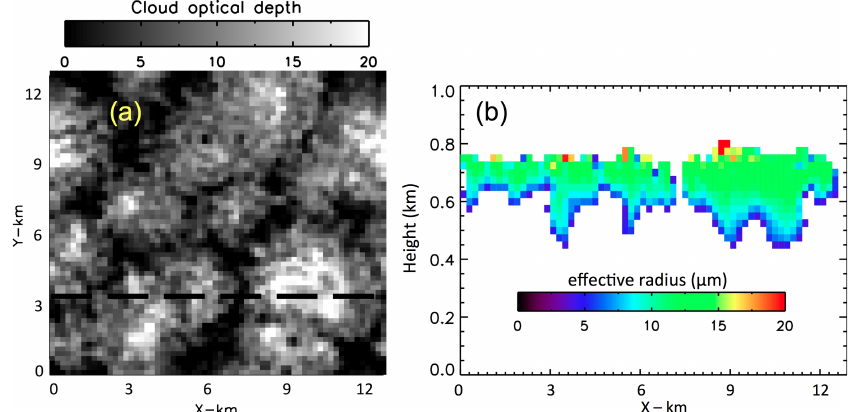
Fig. 4. (a) A Large Eddy Simulation-generated cloud optical depth field used to calculate zenith radiances that are then in turn used to test the retrieval method. Taking a cross-section along the thick black-dashed line (around 3km in the y direction) gives the distribution of effective radii in the x- and vertical directions in (b).